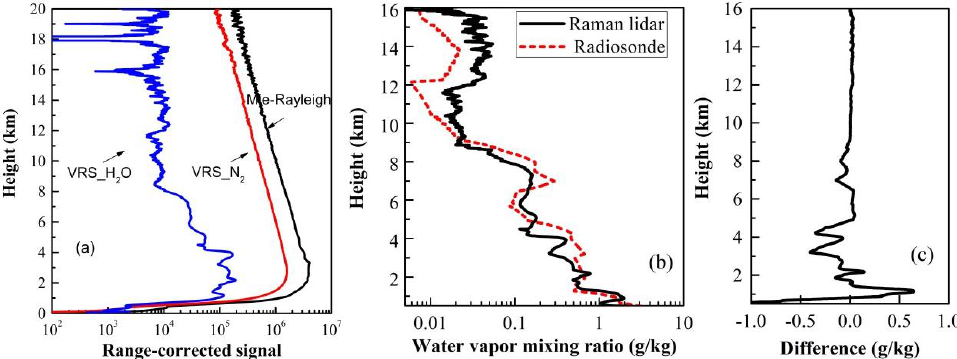
Figure 2. The measured Range-corrected signal of lidar returns, the retrieved water vapor density profile, and comparisons with radiosonde data taken at 20:00 CST on 16 November 2013.